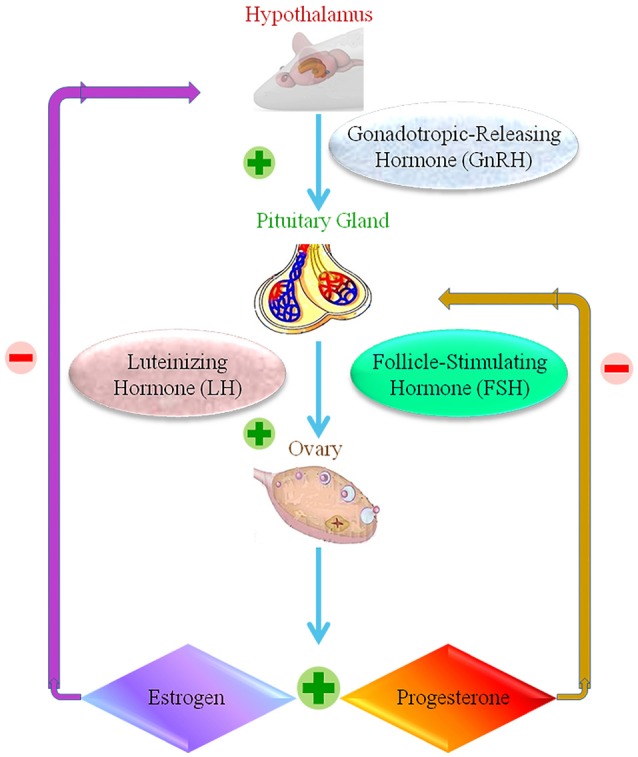
The female reproductive normal operation, showing positive and negative response within the hypothalamic-pituitary ovarian axis.  Stands for positive response.  Stands for negative response.